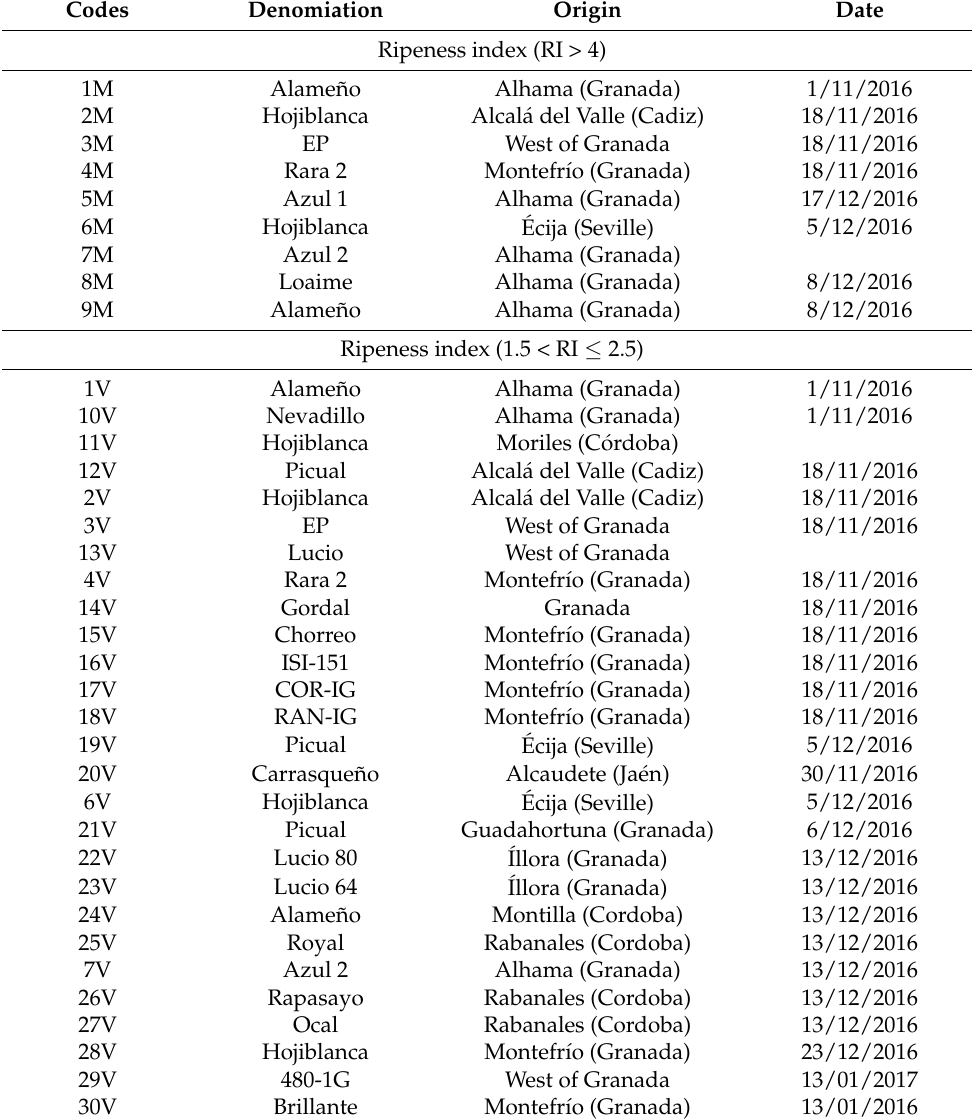
Table 1. Samples of olives used for phenolic solubilization in brine, brine plus acid, and acid